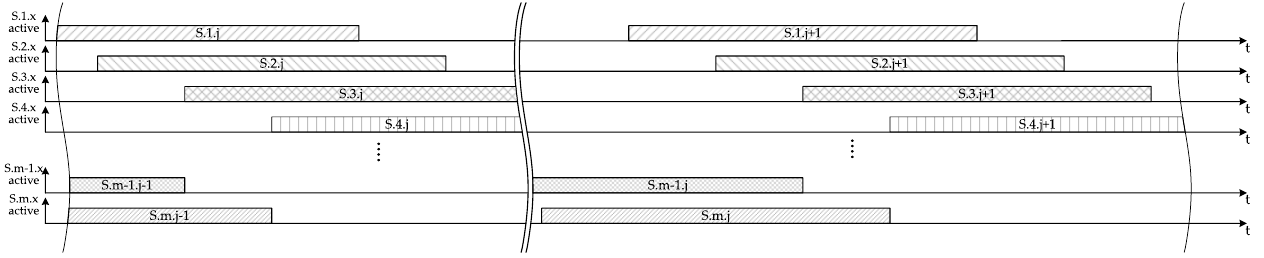
Figure 8. Stator segmentation activity sequence.